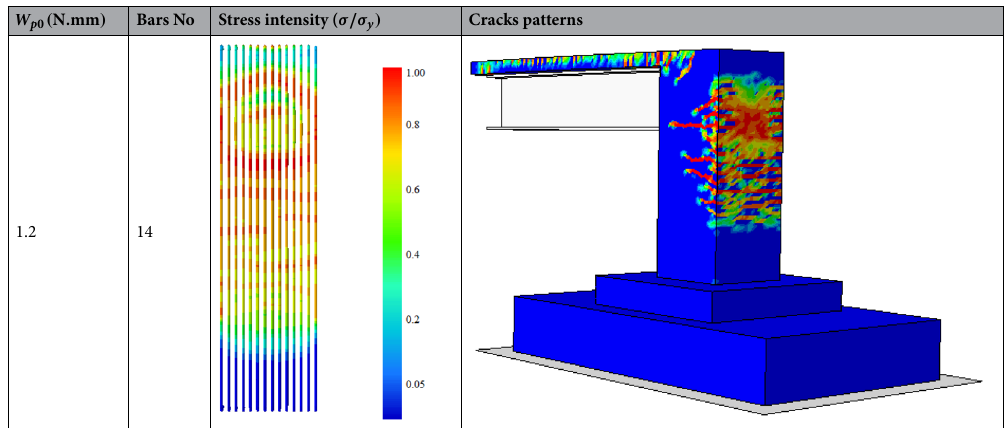
Table 4. W p 0 – Reinforced bars No. effect on the damage